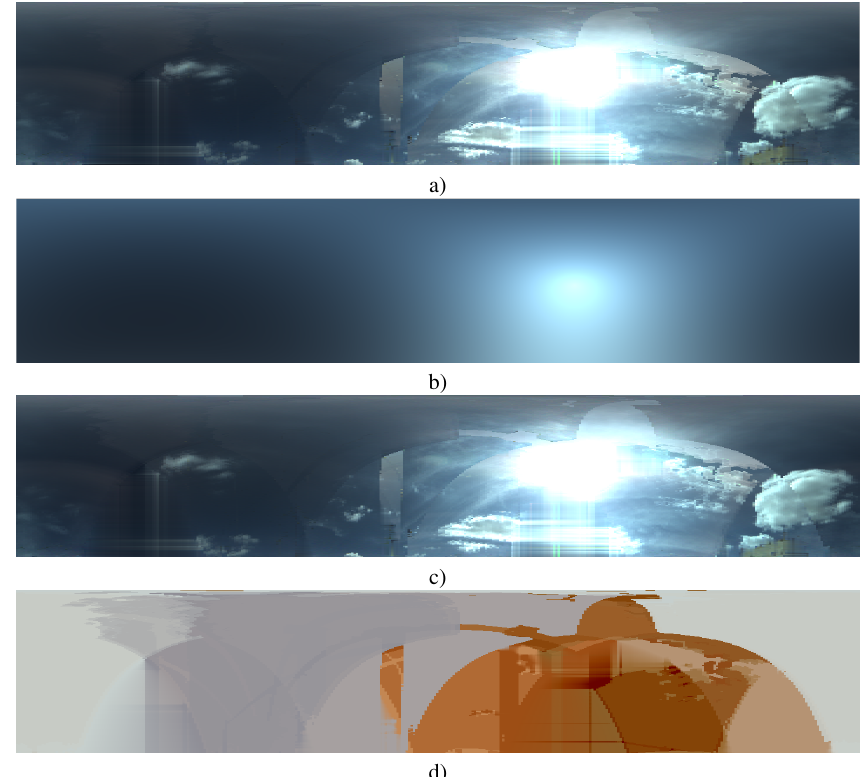
Figure 8: Estimated environment maps: a) Aggregation of sky pixels, b) Perez model and c) Aggregation of corrected sky pixels. The aggregation results are cut for angles close to the horizon, where there is no extracted data. d) Difference between aggregated environment maps with or without correction (different display parameters). The red deviation of artifacts is